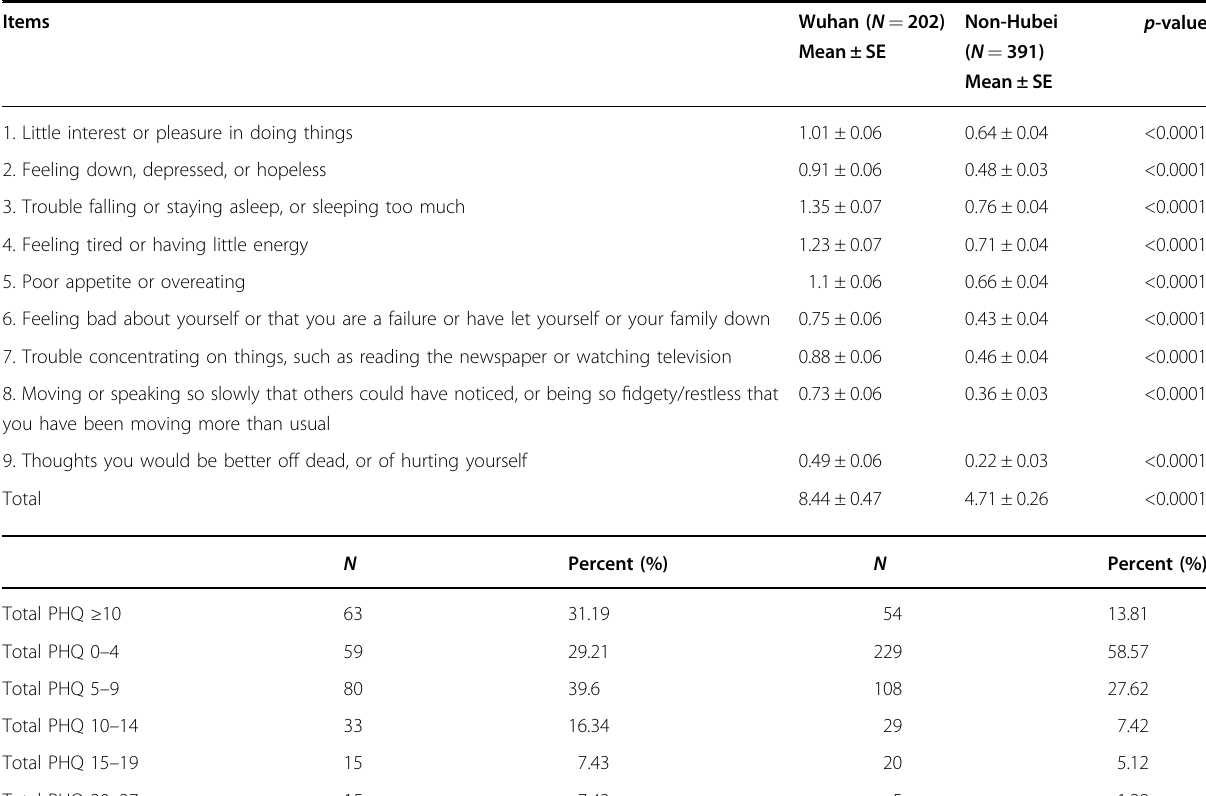
Table 3 Outcomes of PHQ-9 for